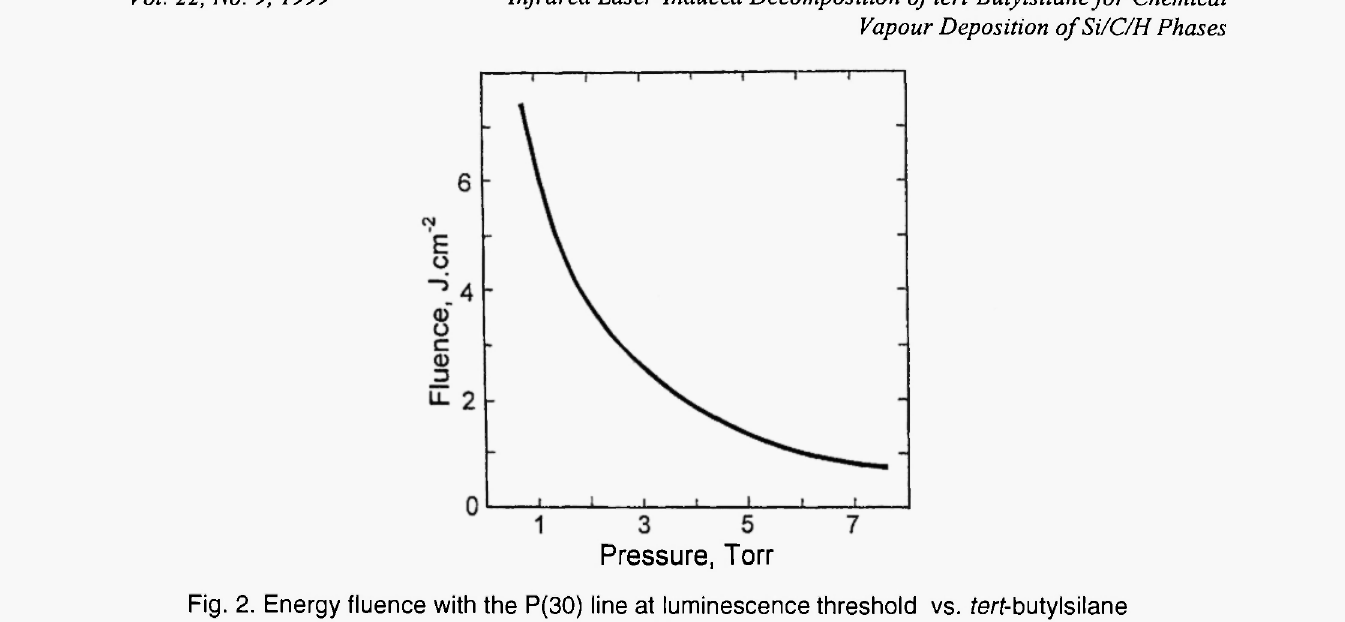
Fig. 2. Energy fluence with the P(30) line at luminescence threshold vs. ferf-butylsilane pressure.